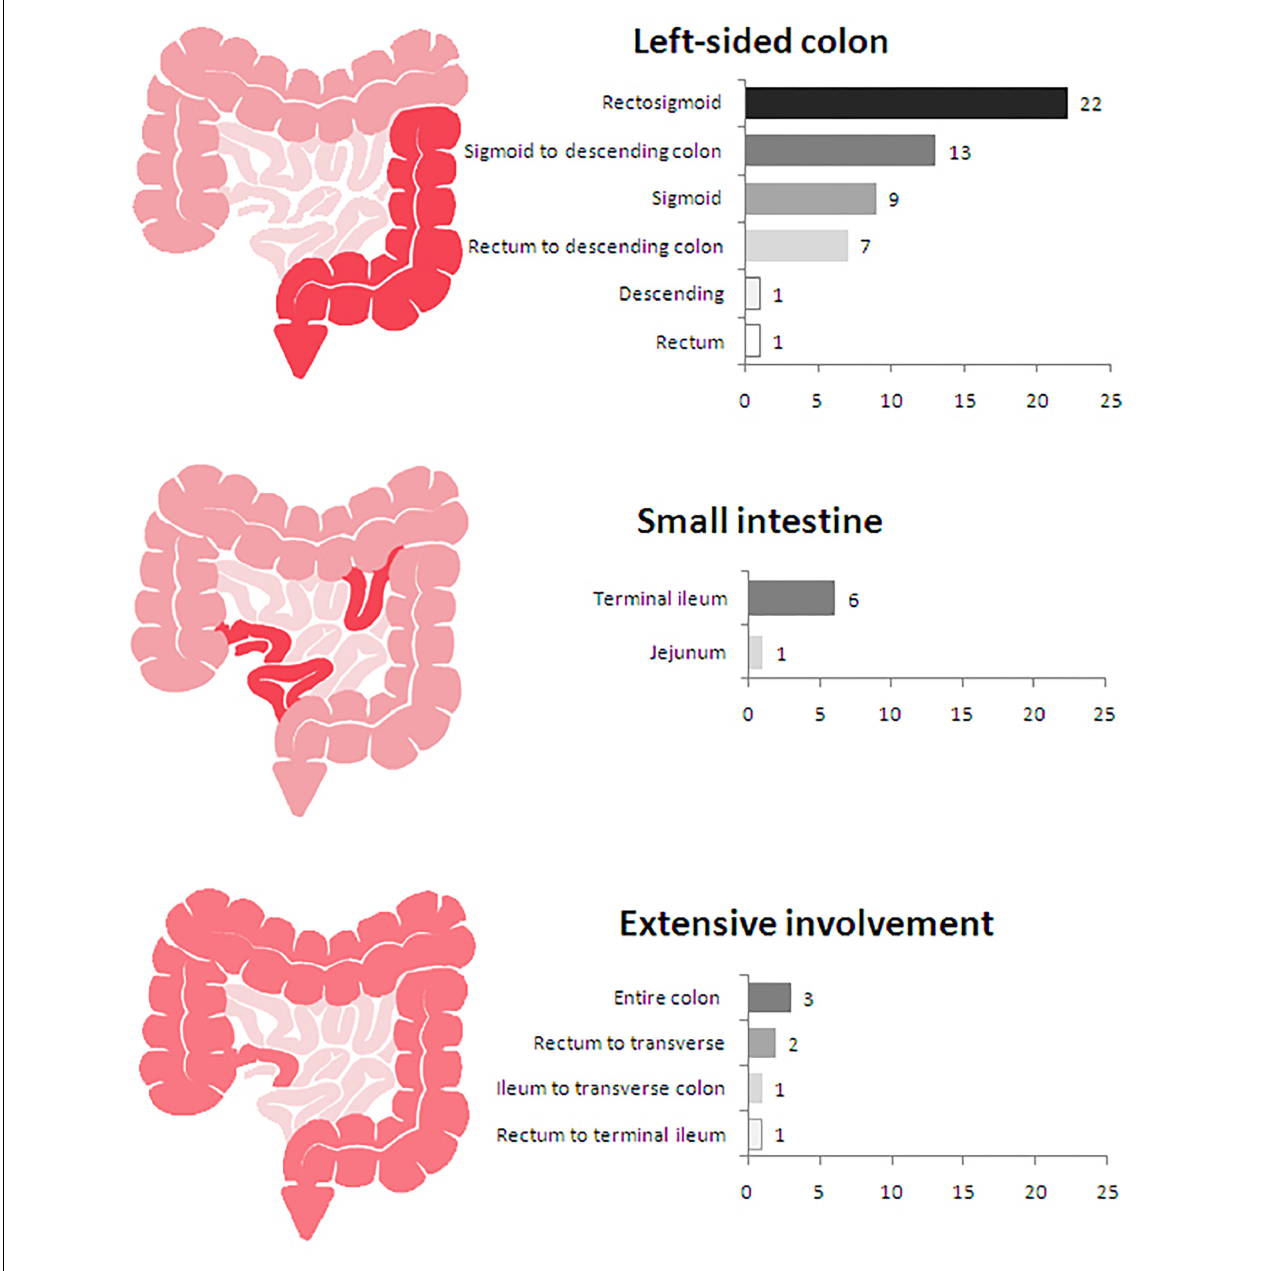
FIGURE 3 | Locations of lesions in 70 patients with idiopathic myointimal hyperplasia of the mesenteric veins (IMHMV).